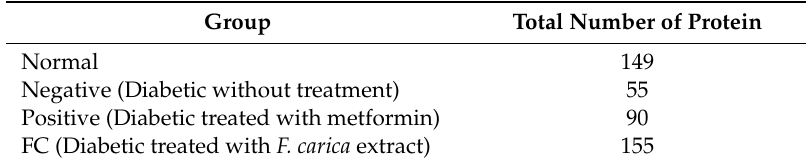
Table 2. The total number of proteins in the sperm sample of FC group and the controls as determined by LC-MS / MS